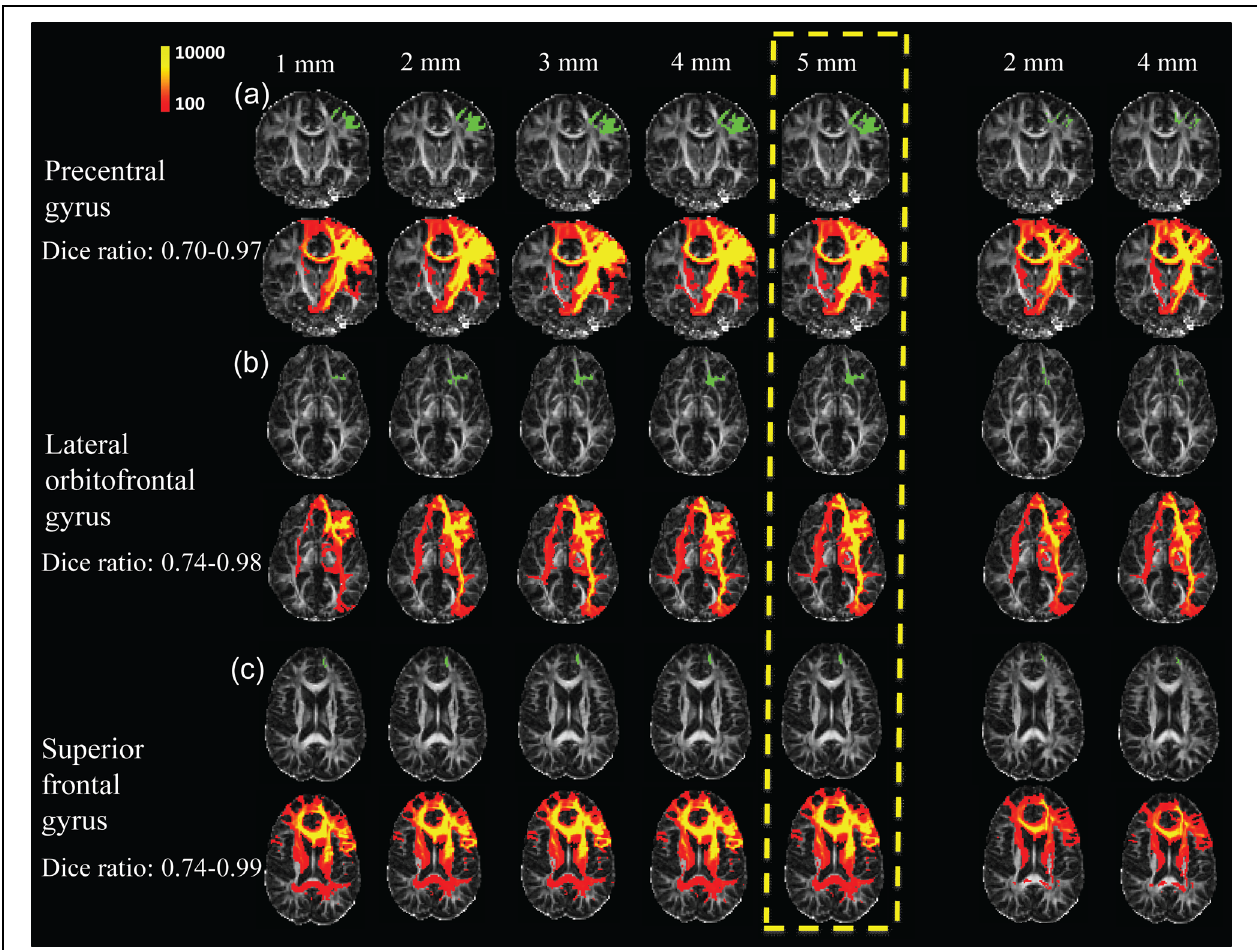
FIGURE 6 | Evaluation test results of WM fibers traced from three representative cortical gyri namely the precentral gyrus (a), lateral orbitofrontal gyrus (b), and superior frontal gyrus (c), assessed by adjusting the seed ROIs used for WM tracing. Two approaches were used to adjust seed ROIs. First, the parcellated cortical gyri were dilated, for distances of 1, 2, 3, 4, and 5 mm (left 5 columns), into the WM. For the second approach, the seed ROIs to initialize tracing were inside WM (right two columns), which were obtained by dilating parcellated cortical gyri by 2 and 4 mm into the WM, and subsequently subtracted by the corresponding cortical gyri dilated by 1 mm. The seed ROIs are shown in green with the WM fibers traced from these ROIs shown in red and yellow directly below them. The upper left color bar encodes the tractography probability. The parcellated cortical gyri dilated by 5 mm was used as seed ROI in the present study, highlighted in yellow dashed